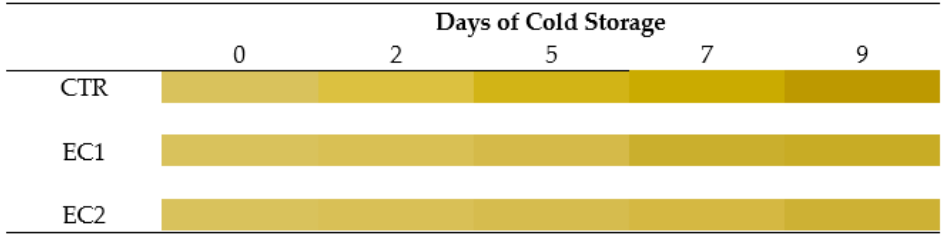
Figure 4. Colour table obtained from the results of the total colour difference ( ∆ E *) recorded in the CIEL* a * b * colour space and converted to the red/green/blue (RGB) scale through the www.e-paint.co website (accessed on 10 November 2021). This figure shows the differences between the coated (EC1 and EC2) and uncoated (CTR) mango cubes at day 0 and after 2, 5, 7 and 9 days of cold storage at 4 ± 1 °C and 80 ± 5% RH.